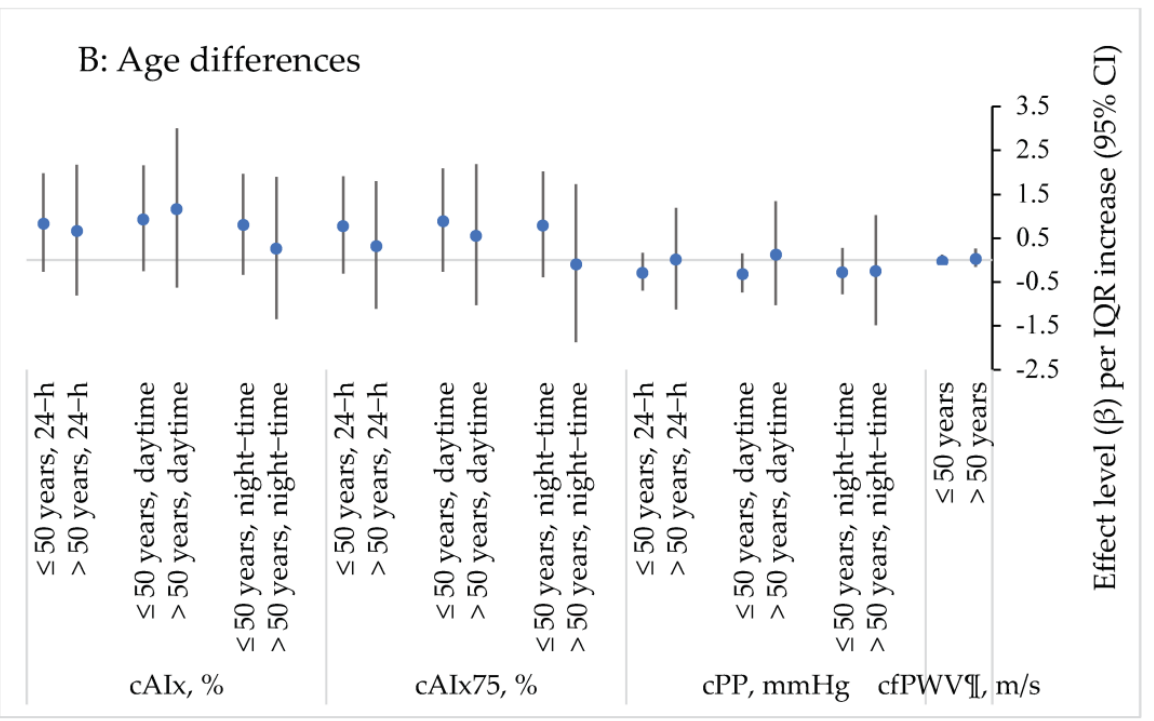
Figure 1. Association between VOCs and measures of arterial stiffness stratified by sex ( A ) and age ( B ). Multiple linear regression; adjusted for age, gender, BMI, waist–hip ratio, socioeconomic status (low, medium, high) and 24-h mean temperature; data are presented as mean change ( β ) and 95% confidence interval (CI) for one interquartile range (IQR) increase in indoor VOCs; cAIx— central (aortic) augmentation index; cAIx75—central (aortic) augmentation index normalised for heart rate; cPP—central (aortic) pulse pressure; cfPWV—carotid–femoral pulse wave velocity; ¶ —this measurement was obtained during the clinical pulse wave analysis assessment (rather than as an ambulatory